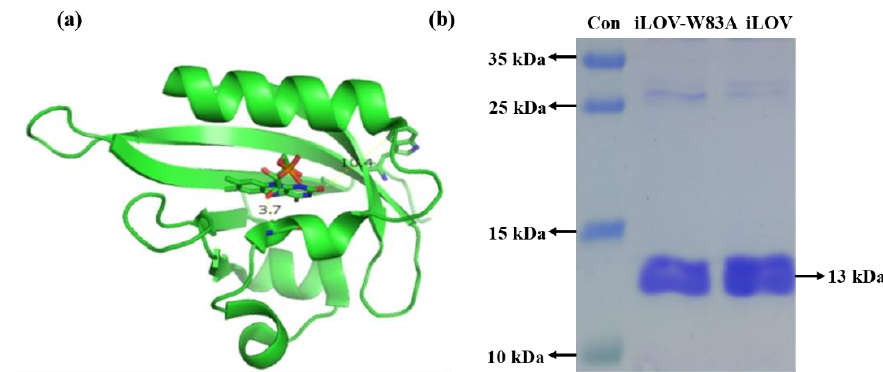
Figure 1. ( a ) Protein model of iLOV (improved light-oxygen-light) ; ( b ) SDS-PAGE analysis of the